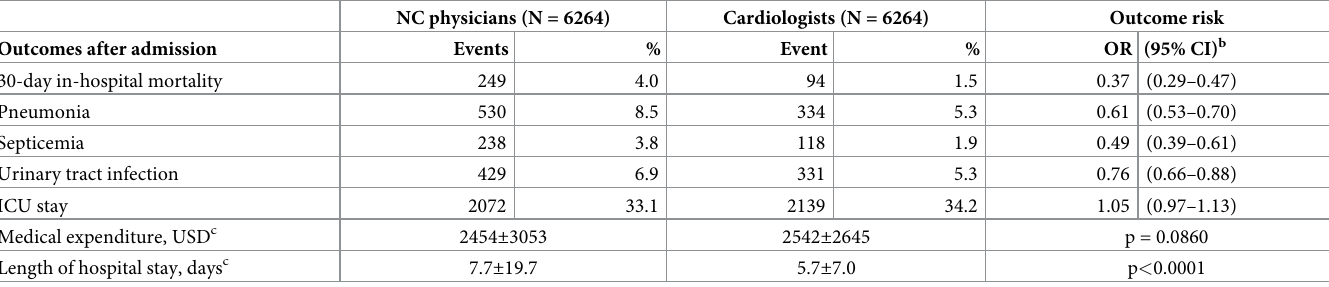
Table 2. Adverse events after admission of heart disease in patients who received care by cardiologists and NC